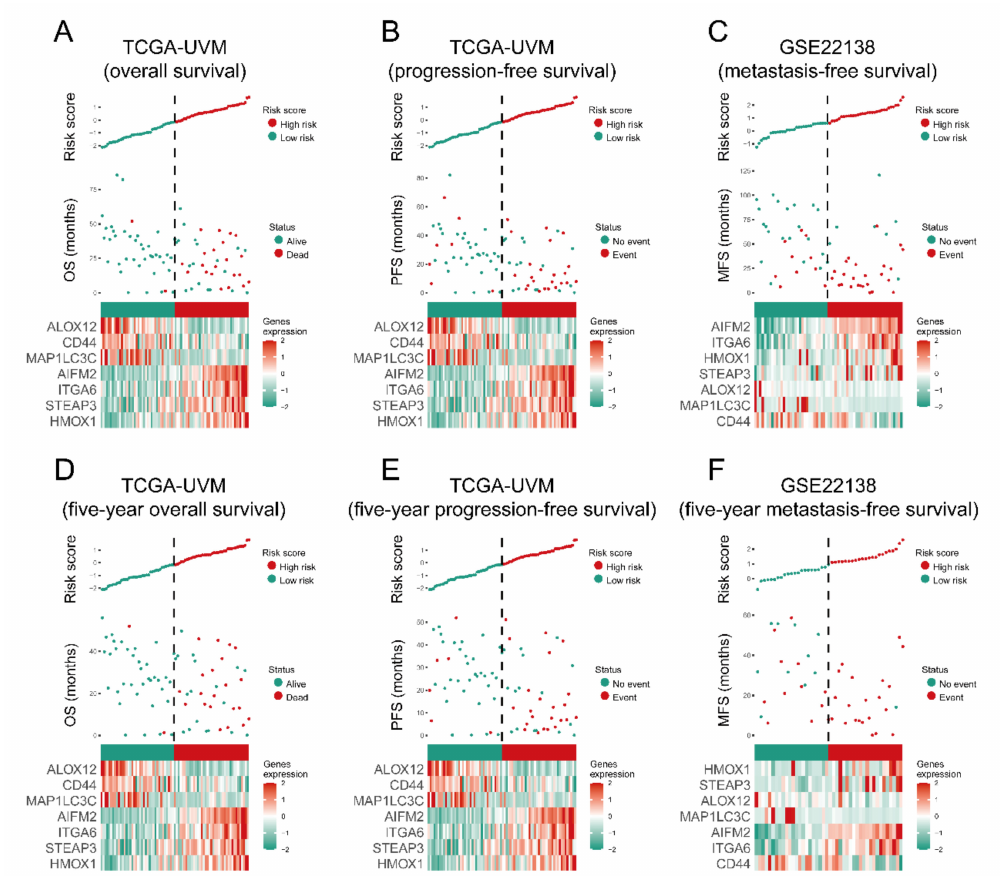
Figure 3. The overall performance of the seven-gene signature in all cohorts. The upper and middle parts of each plot ( A – F ) indicate the distributions of risk score and patients’ survival time, respectively. Bottom parts show heatmaps of seven gene expression